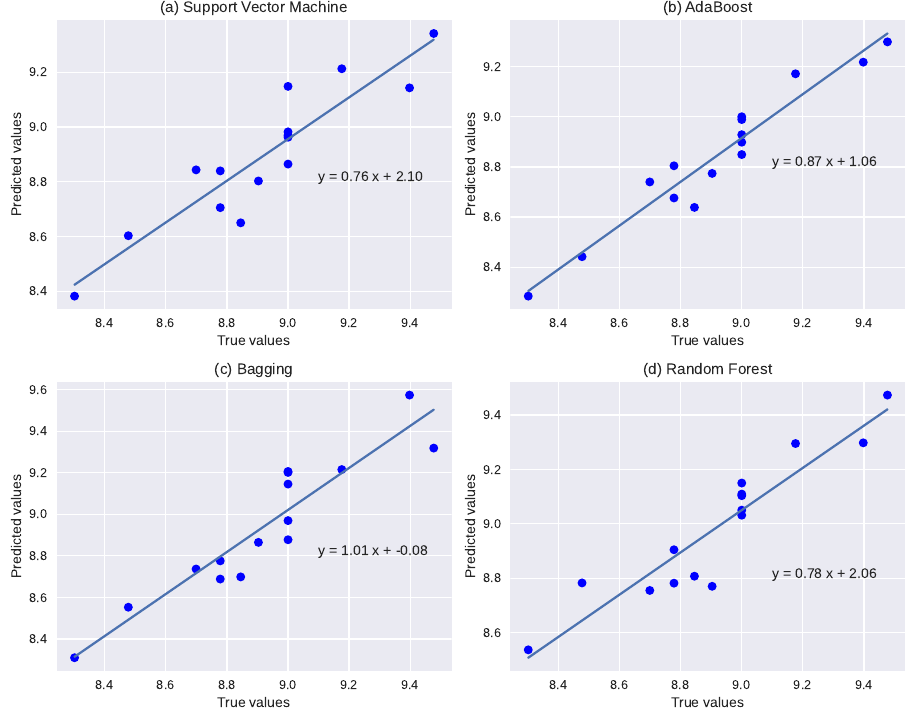
Figure 4. Predicted and true values of M BH for 15 blazars in the test data